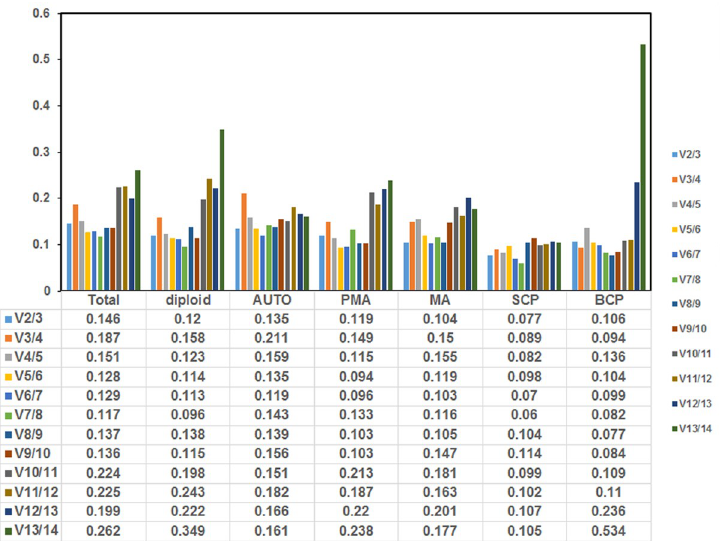
Fig 5. Determination of the optimal number of reference genes for normalization by pairwise variation (V) using geNorm software. The average pairwise variations (Vn/Vn+1) were analyzed to measure the effect of adding reference gene in the qRT-PCR. Total indicate the all samples of diploid and autotetraploid rice. Diploid indicate the all samples of diploid rice; Auto indicate the all samples of autotetraploid rice; PMA indicate the samples of pre-meiosis stage in diploid and autotetraploid rice; MA indicate the samples of meiosis stage in diploid and autotetraploid rice; SCP indicate the samples of single microspore stage in diploid and autotetraploid rice; BCP indicate the samples of bicellular pollen stage in diploid and autotetraploid rice.